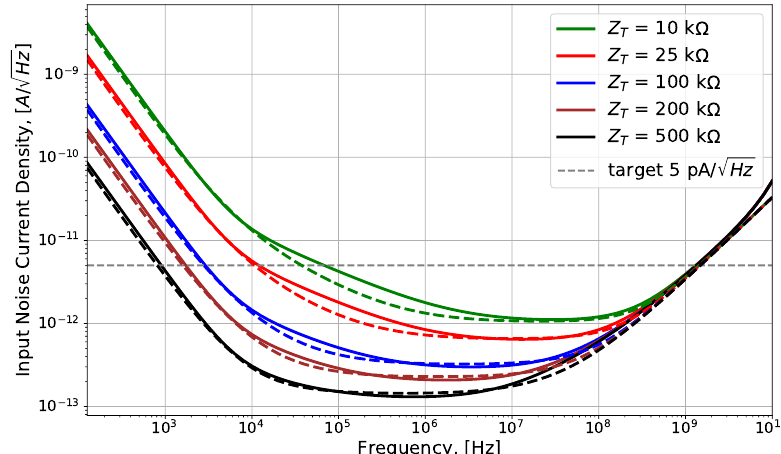
Figure 9. Proposed analytical model for the input-referred noise current density and Cadence- simulated noise for programmable-gain TIA configuration in TSMC 0.18 µ m CMOS. Solid lines are due to Cadence simulation; dashed lines are due to the developed analytical noise model.